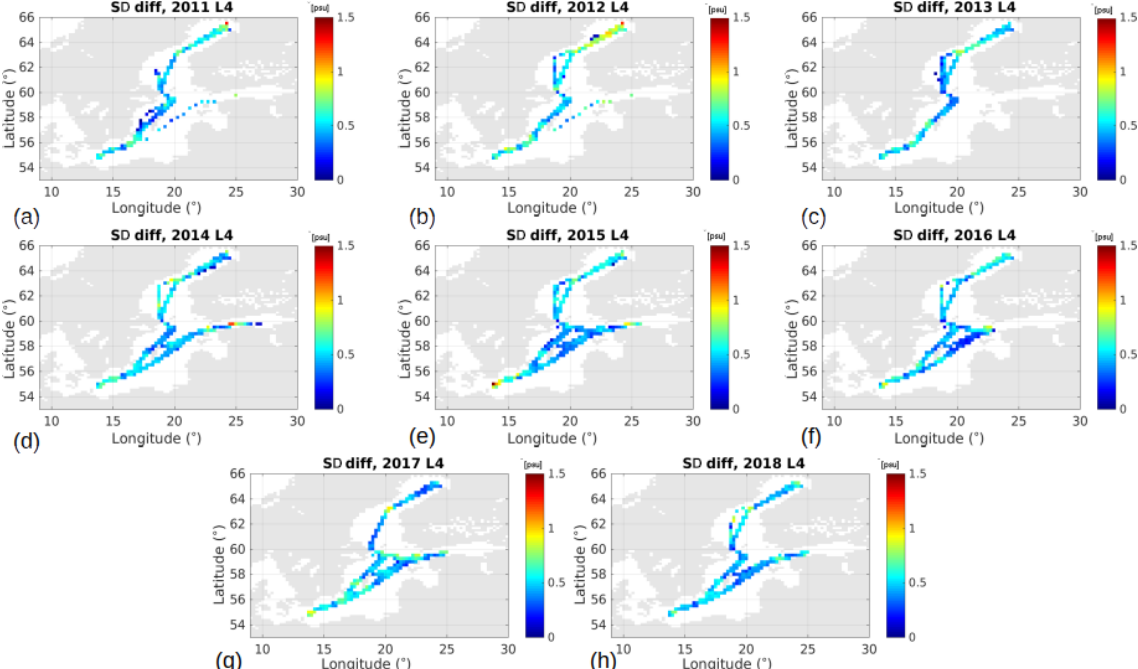
Figure 18. Comparison of L4 SSS and ferry data: spatial distribution of the standard deviation of (cid:49) SSS [psu] per year (from a 2011 to h